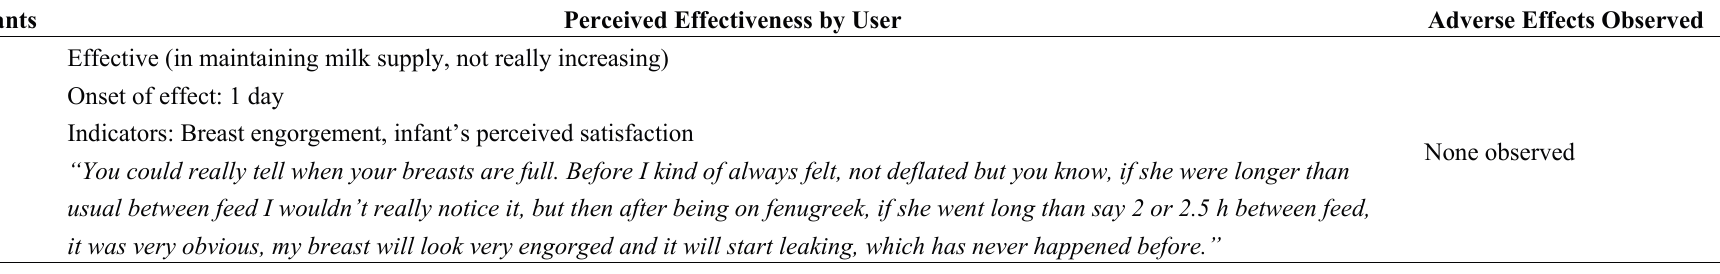
Table 5. Perceived effectiveness and safety: fenugreek and blessed thistle combination